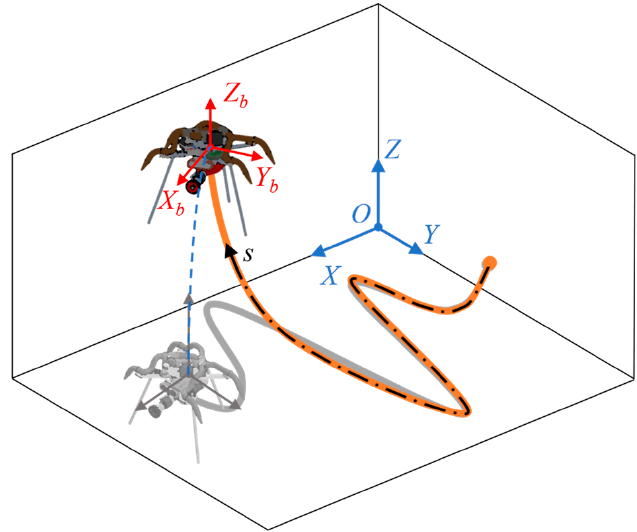
Figure 3. Coordinate systems de fi nition.